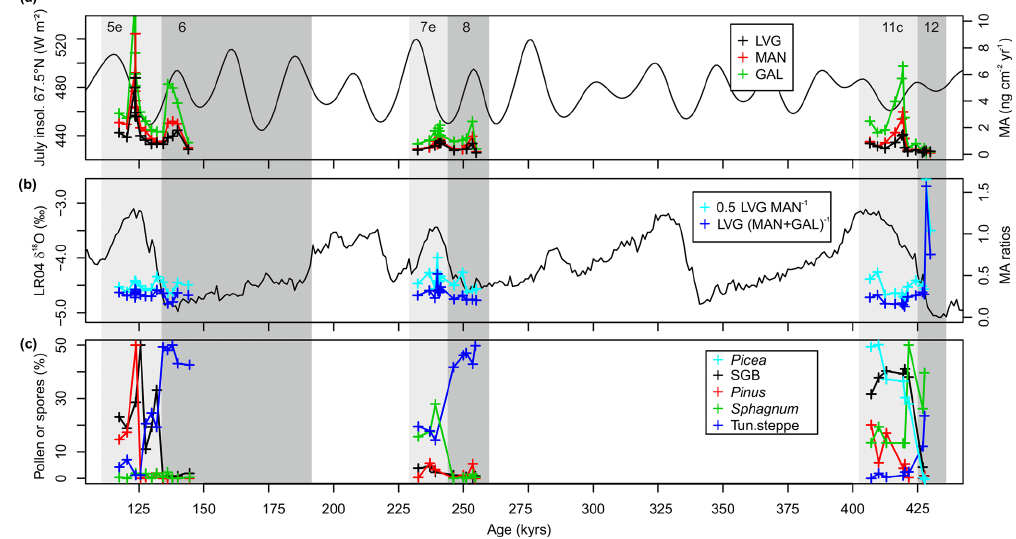
Figure 3. Records of low-intensity fires and vegetation at a centennial timescale. (a) MA influxes against summer insolation (after Laskar et al., 2004); (b) MA ratios against a proxy for past ice-sheet extent (after Lisiecki and Raymo, 2005); and (c) selected pollen records (MIS 6– 5e, 8–7e: this study; MIS 12–11c: after Melles et al., 2012). Tun.steppe (i.e. tundra and steppe taxa reflecting cold and dry glacial conditions): sum of Poaceae, Artemisia , Chenopodiaceae, Caryophyllaceae, Cichoriaceae and Thalictrum pollen; summergreen boreal forest taxa (SGB): sum of Larix , Populus, and Alnus pollen; Pinus s/g. Haploxylon -type pollen (with SGB and Pinus spreading during interglacials); and the Sphagnum spore abundance (representative for peatlands).